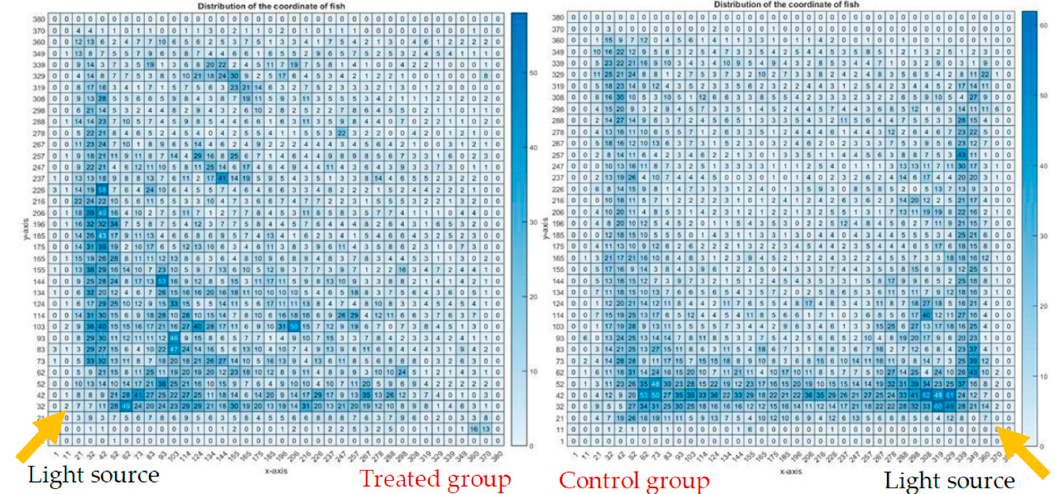
Figure 12. Heatmap charts in pixel format showing the fish being observed in a particular pixel in terms of the coordination of the fish.